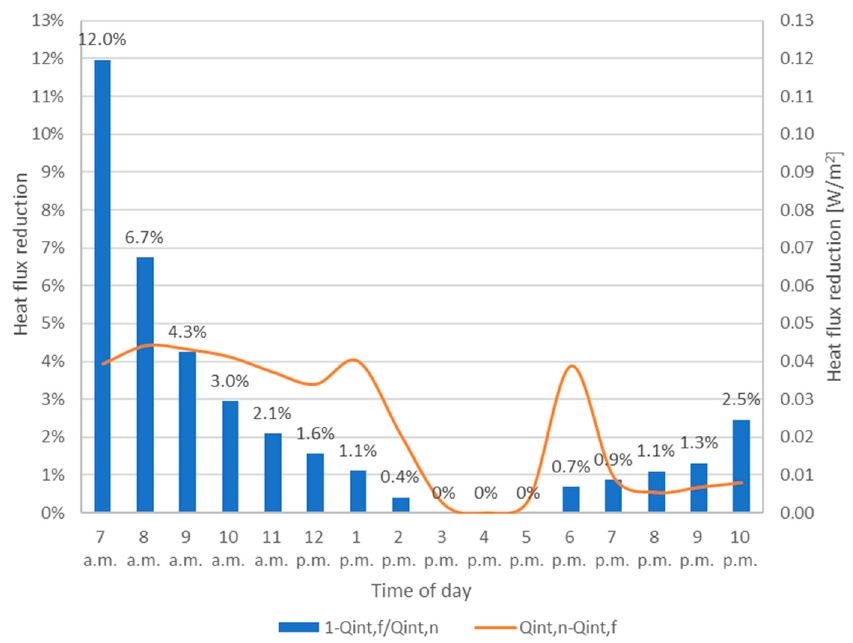
Figure 9. Hourly reduction of the heat flux entering the building provided by using forced ventilation (Q int,f ) instead of natural ventilation (Q int,n ).